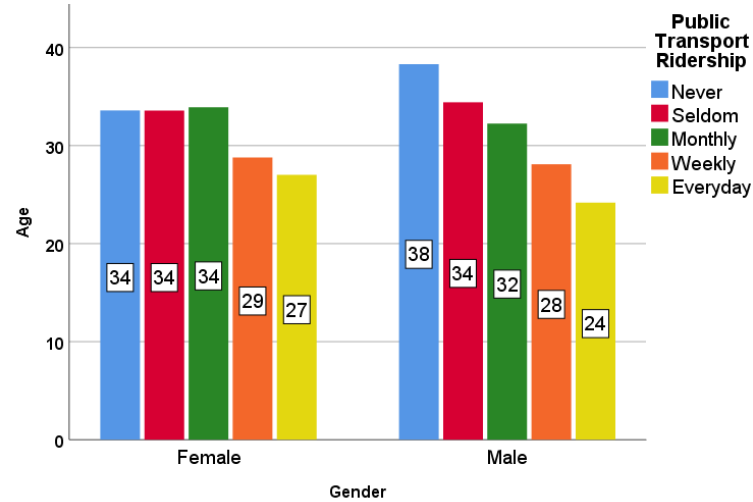
Figure 2. Distribution of public transport ridership levels among different ages and genders. Table 5. Binomial logistic regression model of public transportation ridership in Kerman (N = 791).